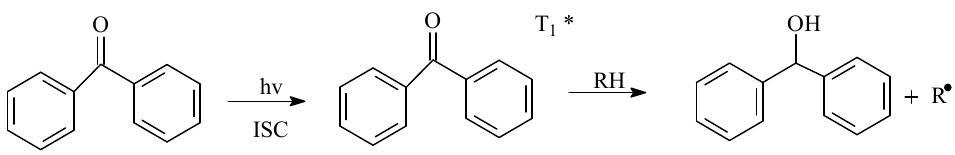
Figure 2. Tensile strength as a function of photoinitiator concentration.